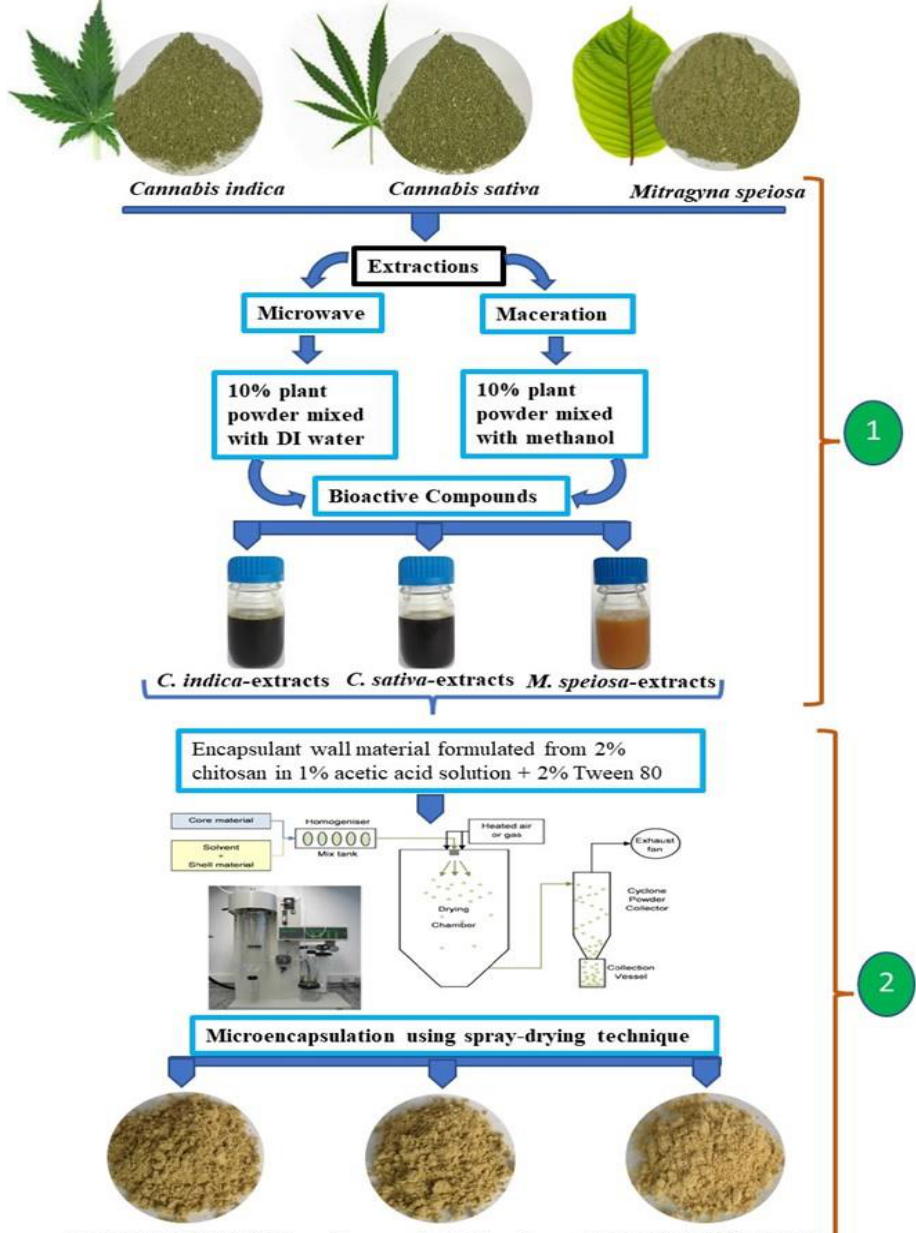
Figure 1. Procedure for bioactive compound extraction (1) and the microencapsulation formulation processing steps (2).